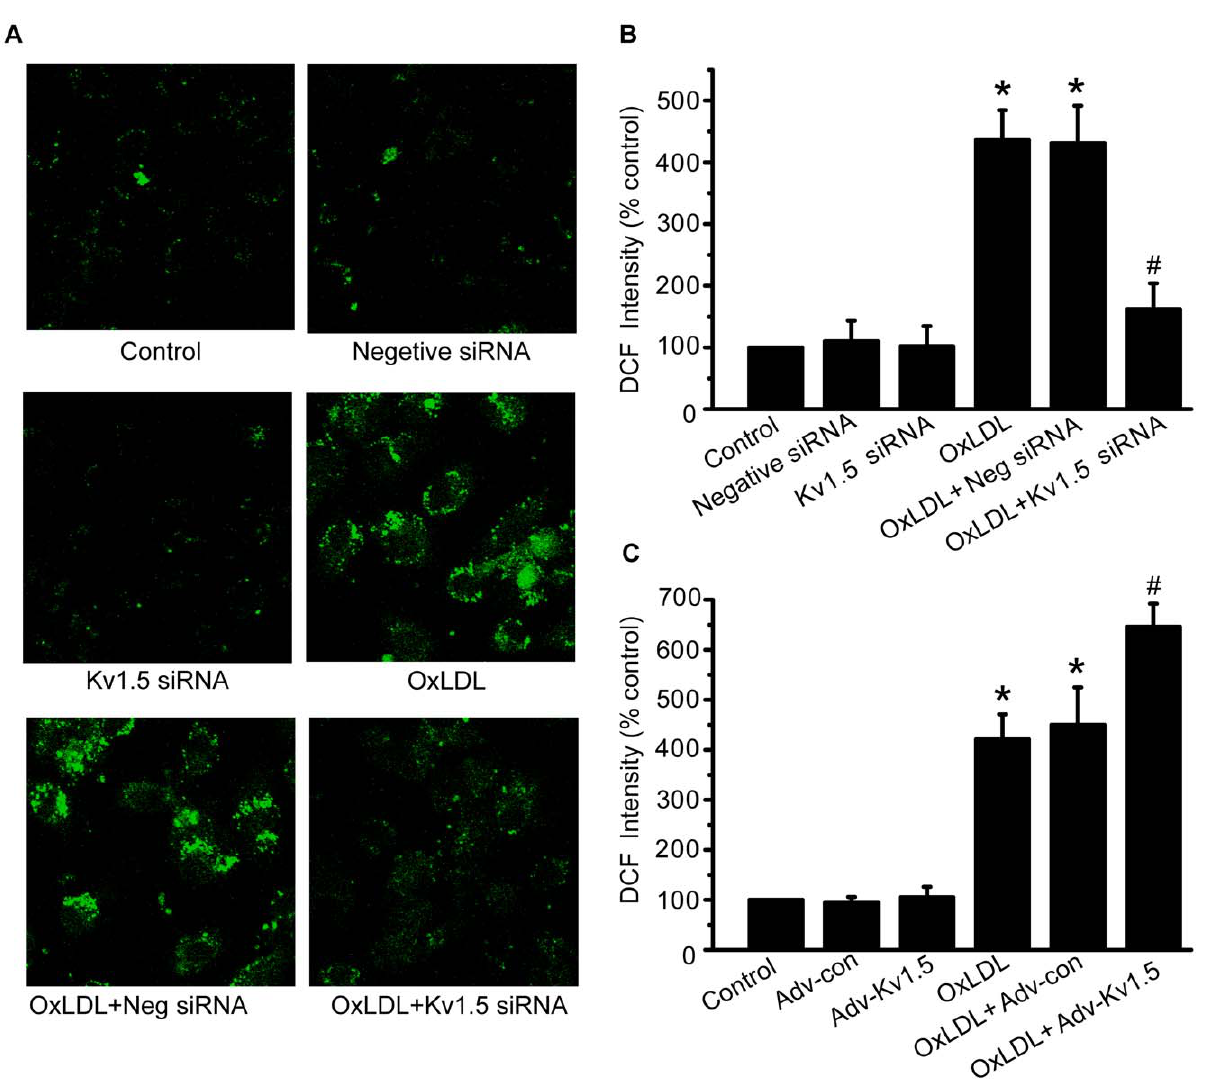
Figure 5. OxLDL-induced ROS overproduction was attenuated by Kv1.5 siRNA, but exaggerated by Kv1.5 overexpression. Intracellular ROS levels were detected using DCFH-DA staining in HPAECs transfected with Kv1.5 siRNA (10 nM) or infected with adnovirus containing KCNA5 , which were treated with oxLDL (150 m g/ml) for further 1 h. ( A ) & ( B ). Kv1.5 siRNA significantly attenuated oxLDL-induced endothelial ROS overproduction in HPAECs, as demonstrated by representative images from laser scanning confocal microscopy and bar graph showing fluorescence intensity measured in Multi-Mode Microplate Reader. ( C ). Bar graph shows that adnoviral KCNA5 gene transfer exaggerated oxLDL-induced endothelial ROS overproduction in HPAECs. The values are presented as means 6 SEM of 6 independent experiments. * P , 0.05, ** P , 0.01 vs. Vehicle control; # P , 0.05, ## P , 0.01 vs. Ad-con.